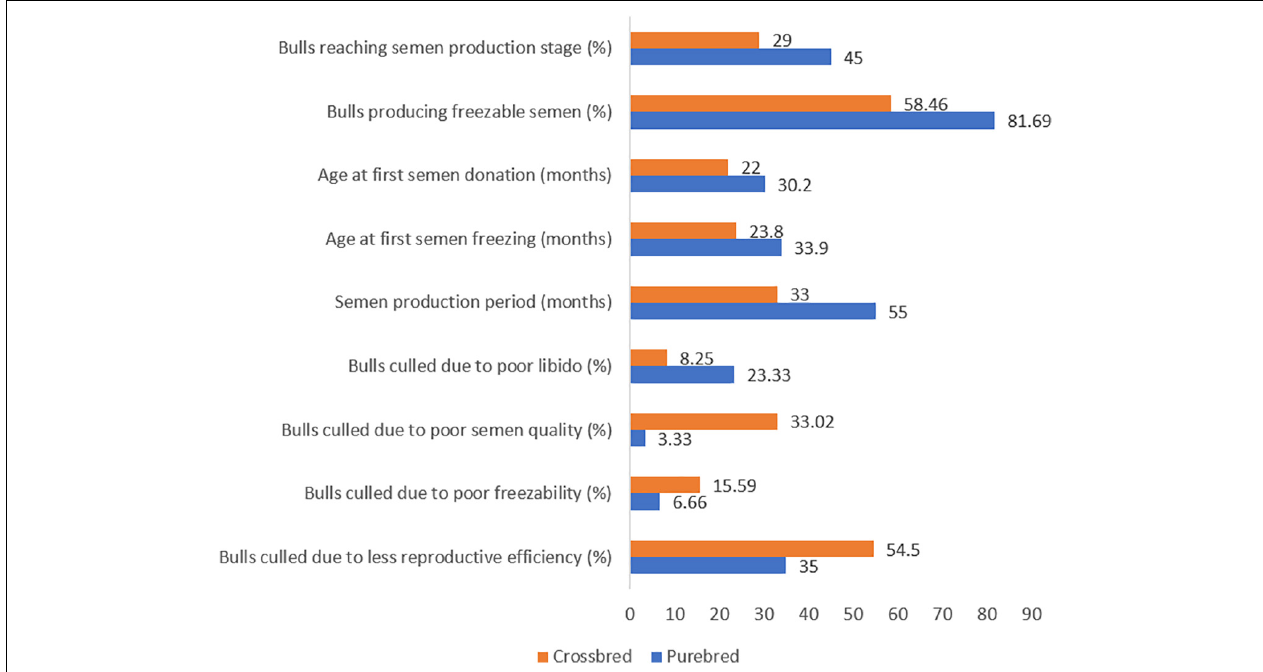
FIGURE 1 | Culling pattern and semen production characteristics in purebred and crossbred bulls (based on the data from Suryaprakasam and Rao, 1993; Rao and Rao, 1995; Rao et al., 1995; Khate, 2005; Mukhopadhyay et al.,